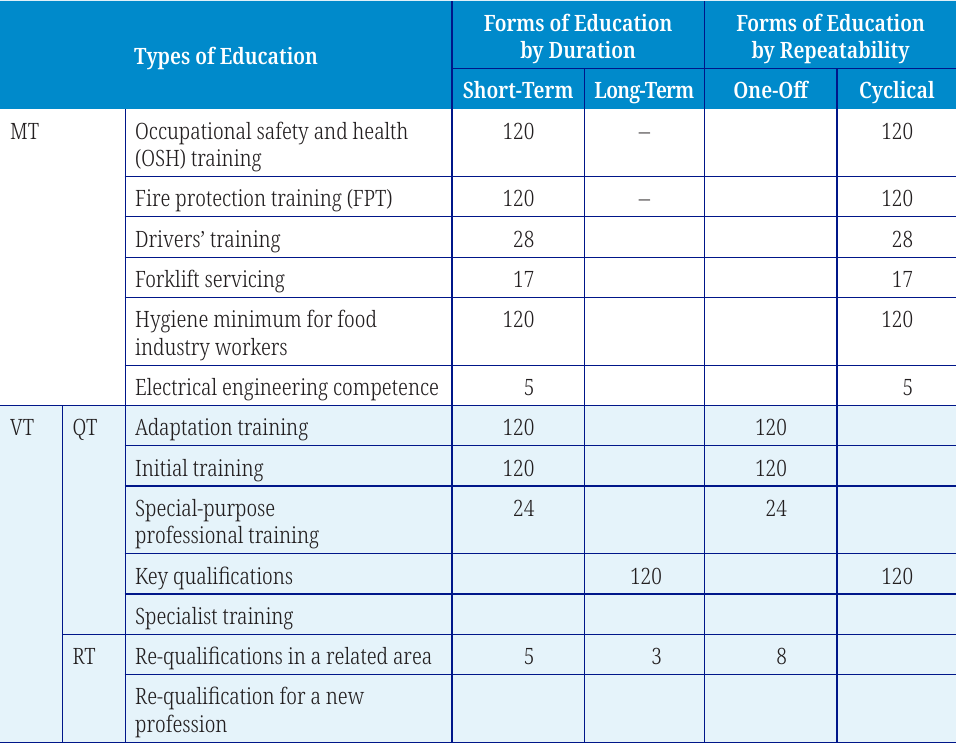
Table 2. Types of education by their duration and